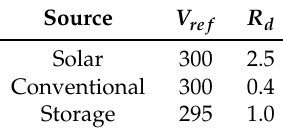
Table 5. Traditional droop control settings for patrol base (PB) simulation.